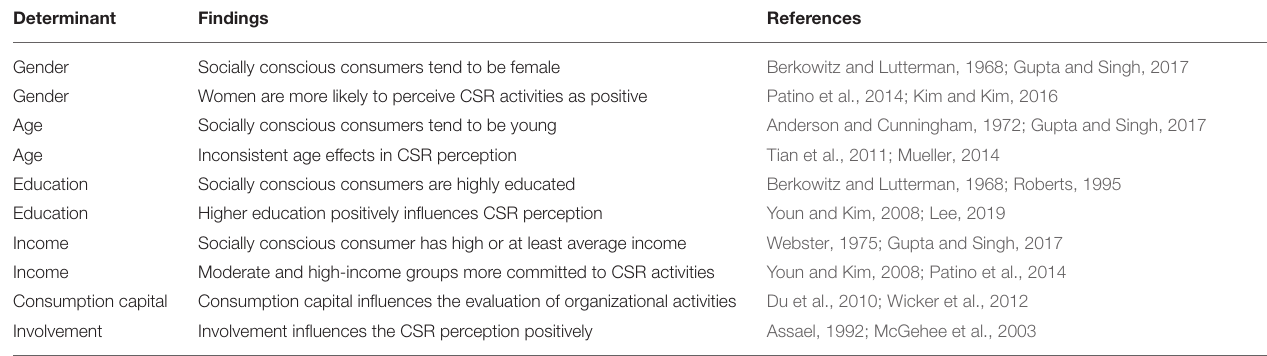
TABLE 2 | Summary of determinants of CSR